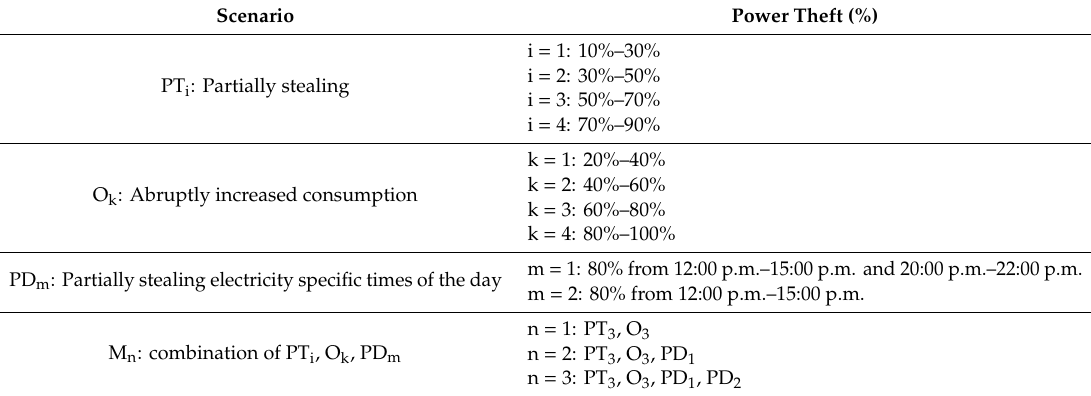
Table 1. The proposed power theft scenarios based on realistic consumers’ behavior cases.